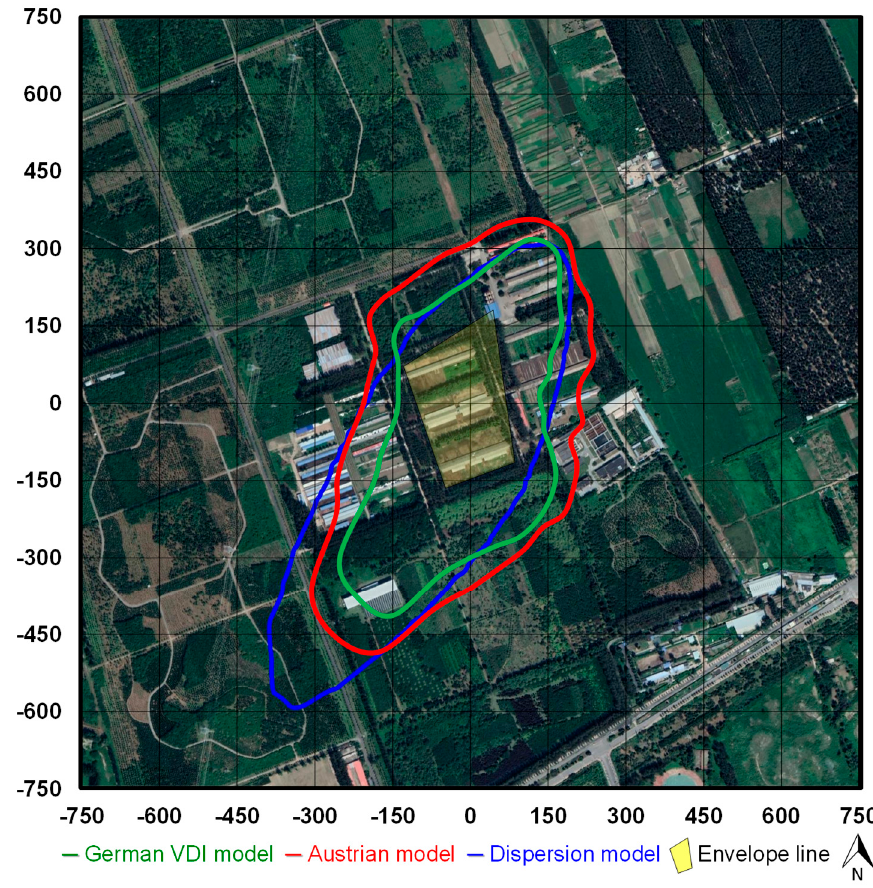
Figure 4. Separation distances around the dairy farm determined by the Austrian and the German VDI empirical models as well as the AERMOD dispersion model for an exceedance probability of P = 15%. The emission focal point lays in the origin of the coordinate system at 0,0 (in metres).